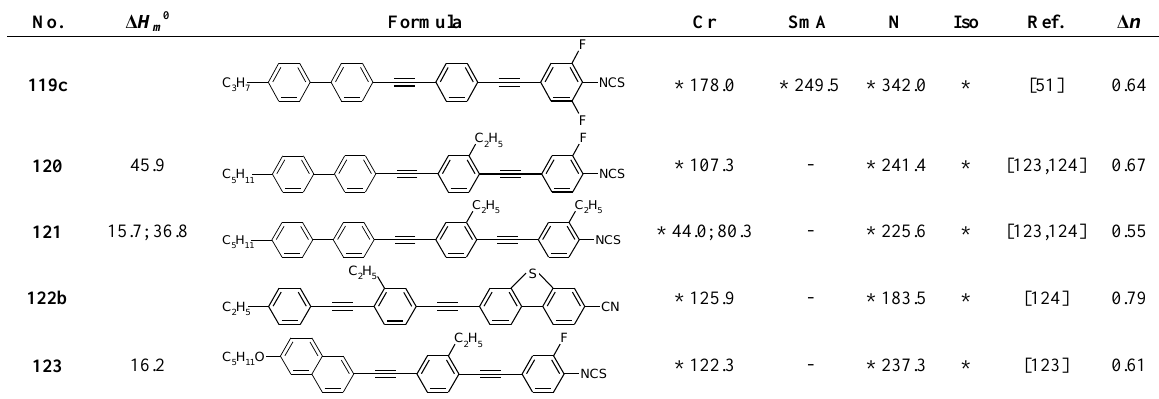
Table 16. Phase transition temperatures [°C], melting enthalpies [kJ/mol] and birefringence of four-ring